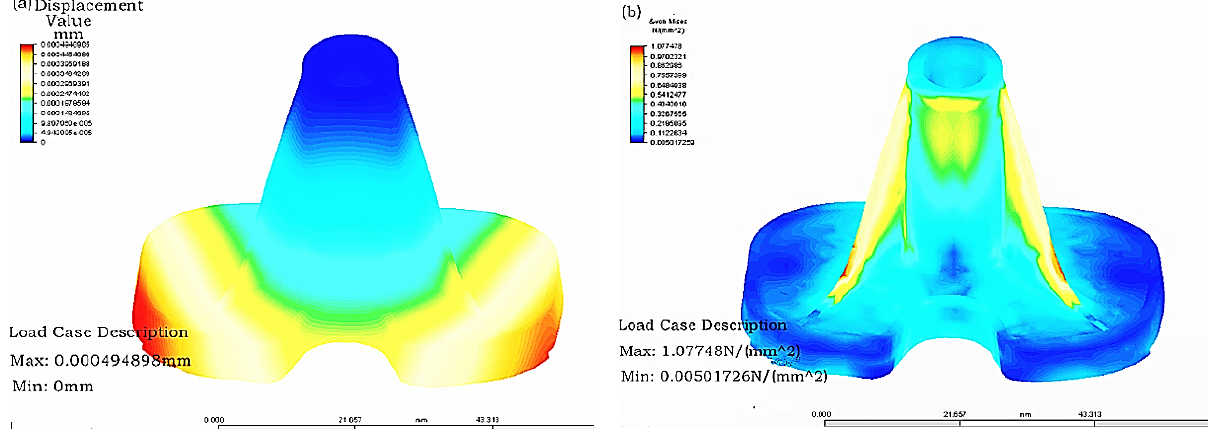
Figure 6. Optimization results of tibial implant: ( a ) Displacement distribution; and ( b ) Stress distri- bution.